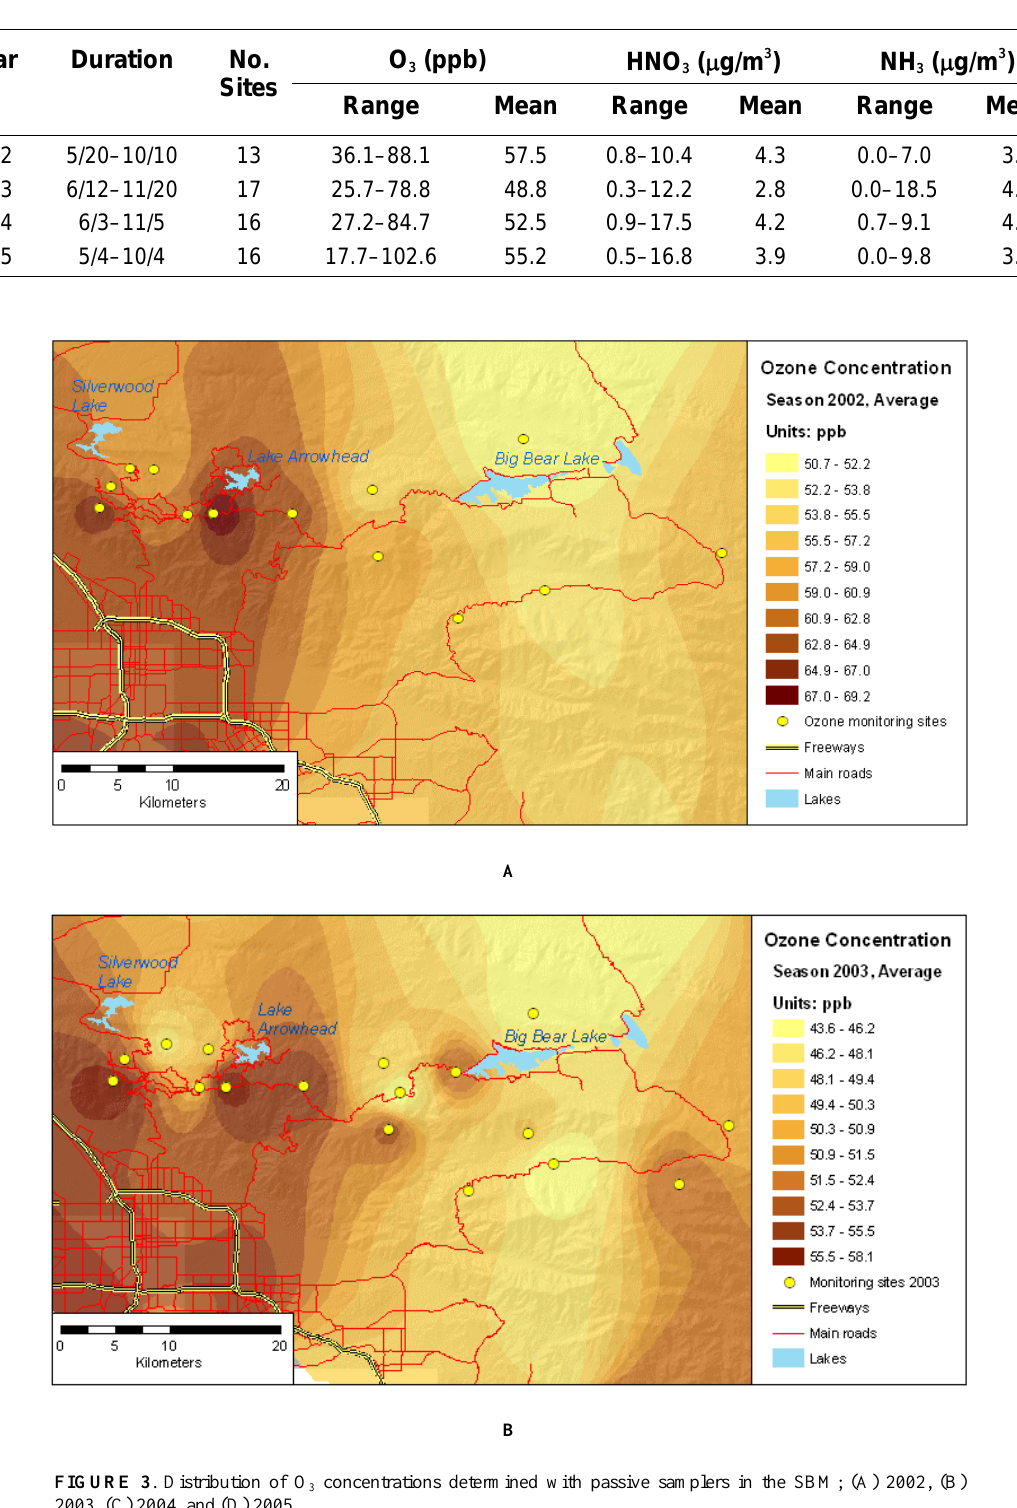
FIGURE 3 . Distribution of O 3 concentrations determined with passive samplers in the SBM; (A) 2002, (B) 2003, (C) 2004, and (D)